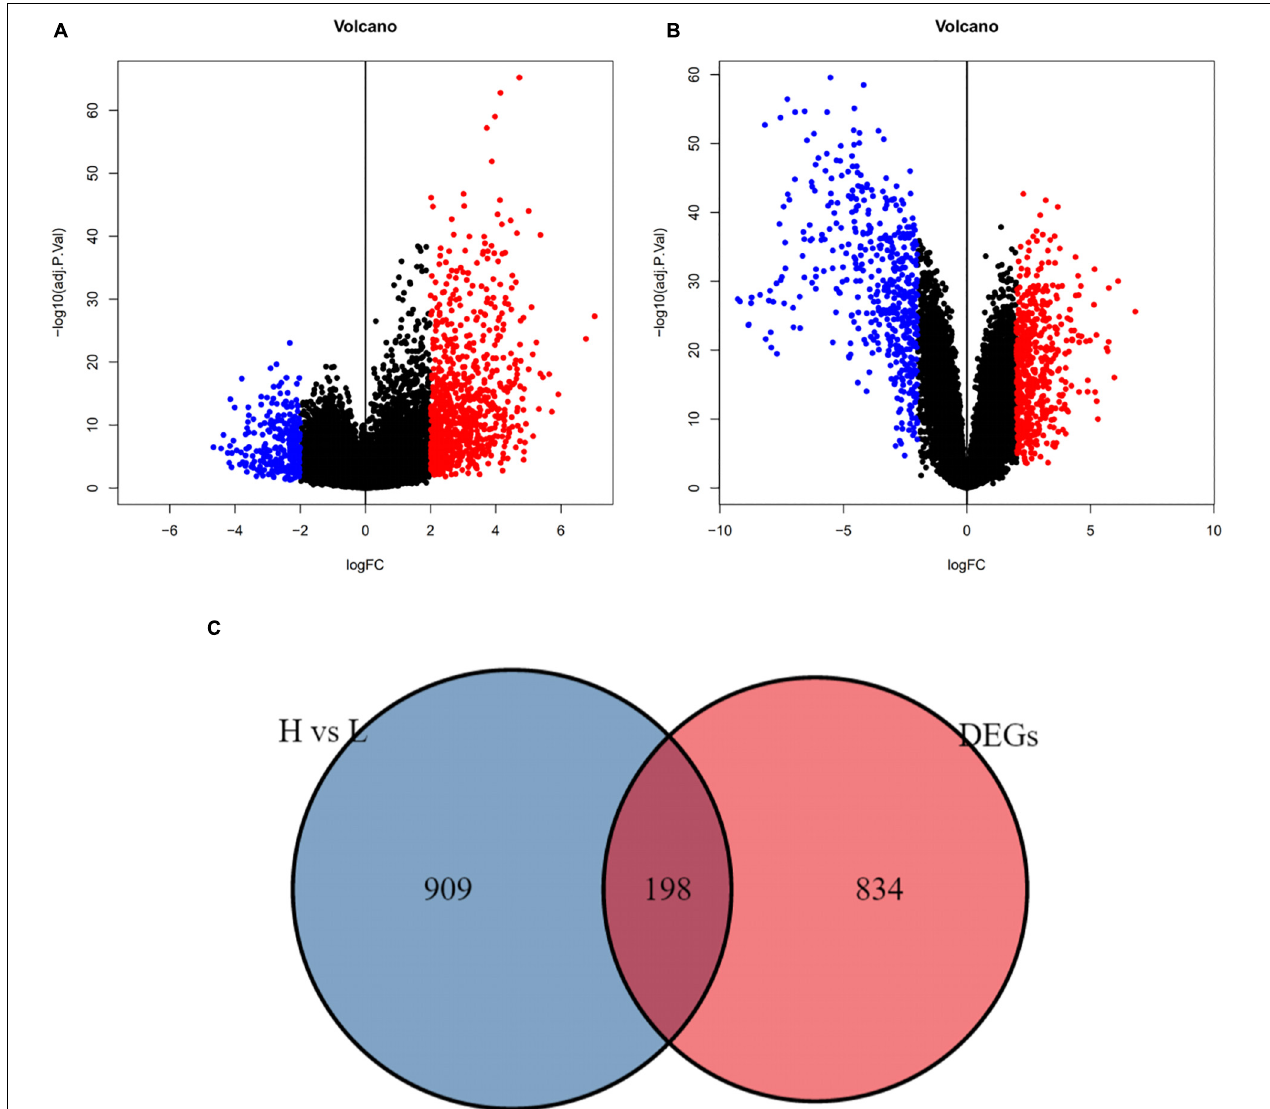
FIGURE 4 | Immune – related differential genes were defined. (A) The volcano plot showed different genes between high and low immune cell infiltration cluster (adj. p -value < 0.05). (B) The volcano plot showed different genes between ES and normal skeletal muscle cells (adj. p -value < 0.05). (C) Using draw Venn diagram to pick up the intersection, 198 differentially expressed genes were